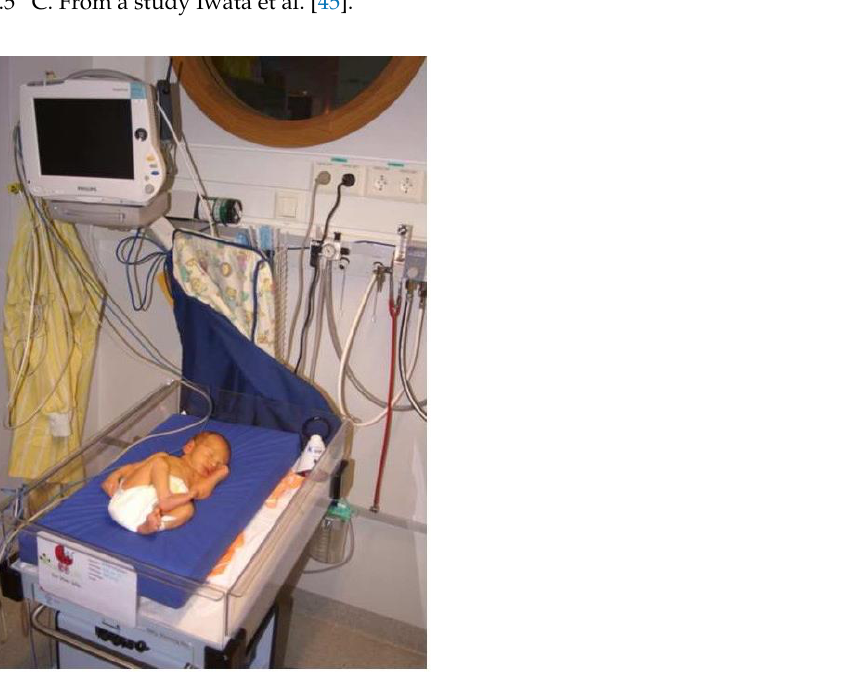
Figure 8. Baby being cooled on a PCM-mattress (blue) in a neonatal ward. With permission from the parents. The mattress contains PCM and a layer of soft material.